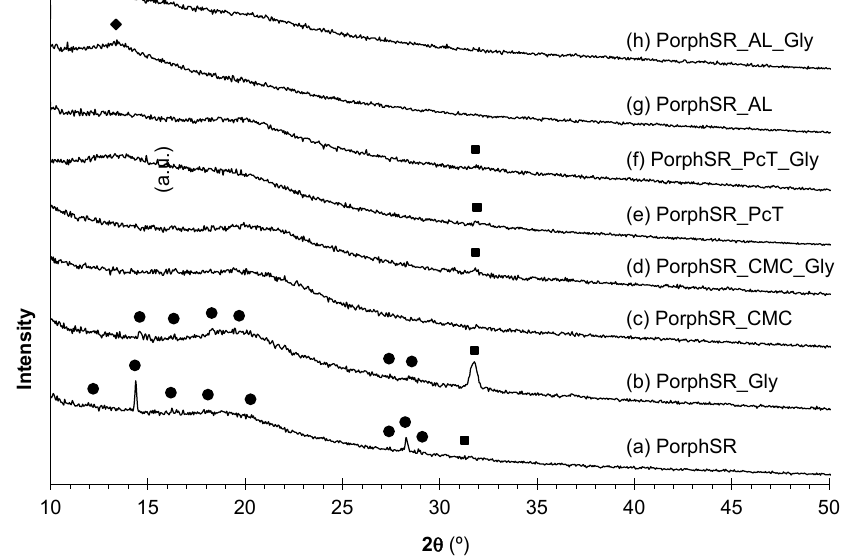
Figure 6. Diffractograms obtained for porphyran-based films: (a) PorphSR; (b) PorphSR_Gly; (c) PorphSR_CMC; (d) PorphSR_CMC_Gly; (e) PorphSR_PcT; (f) PorphSR_PcT_Gly; (g) PorphSR_AL; (h) PorphSR_AL_Gly. ( galactose, ICDD 09-0620; NaCl, ICDD 01-0994; alginate [32].)